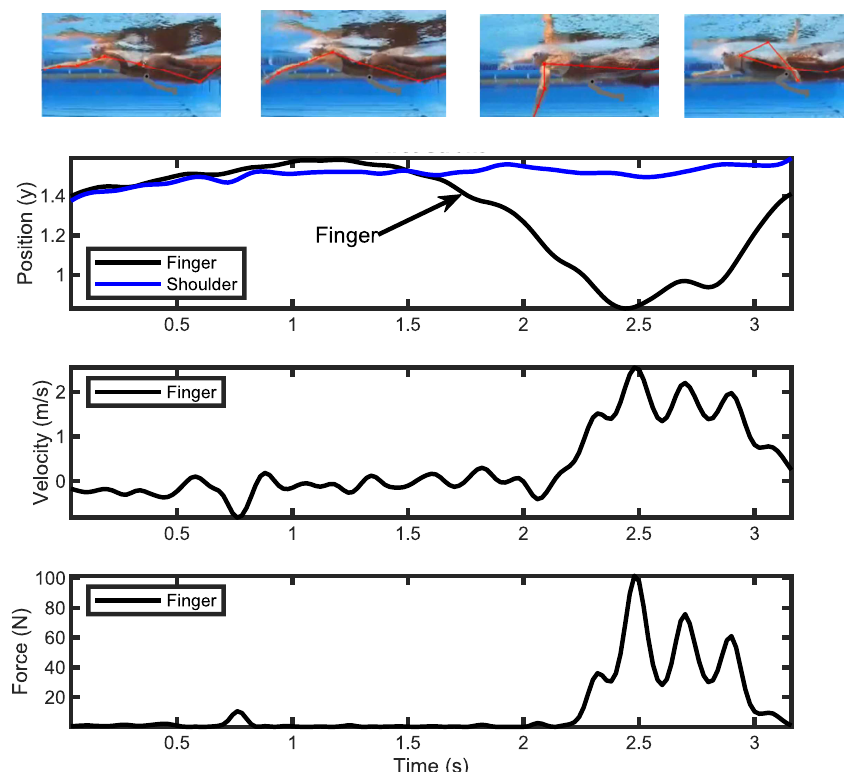
Figure 2. Temporal tracking of position, velocity and estimated force of the left finger of the swimmer during front crawl arm stroke. The insets at the top of the figure depict the sequence of movements that the swimmer was performing while completing one stroke with the left